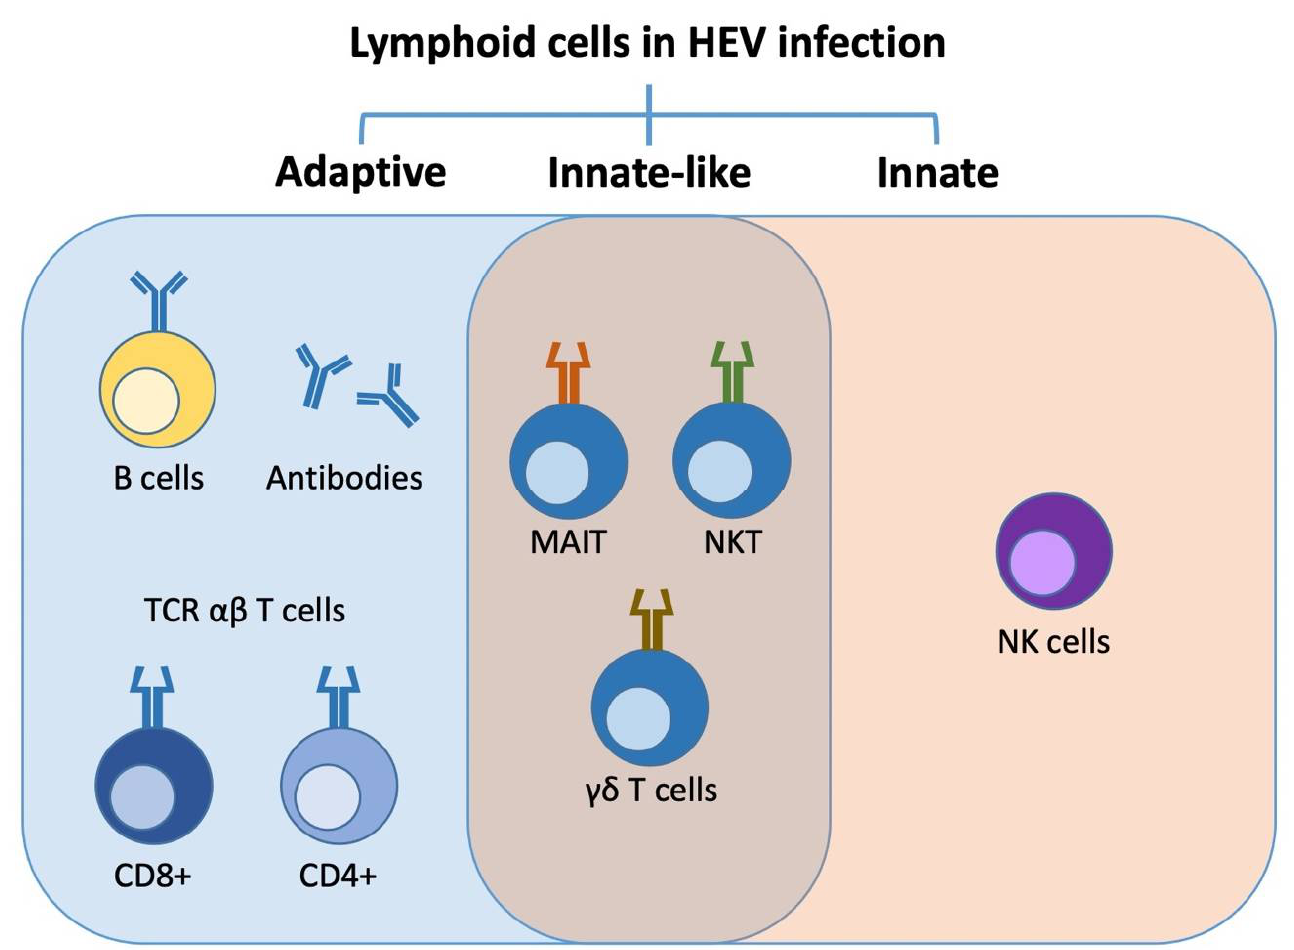
Figure 3. The immune response induced by HEV infection comprises the interaction of adaptive, innate-like, and innate lymphoid cells.